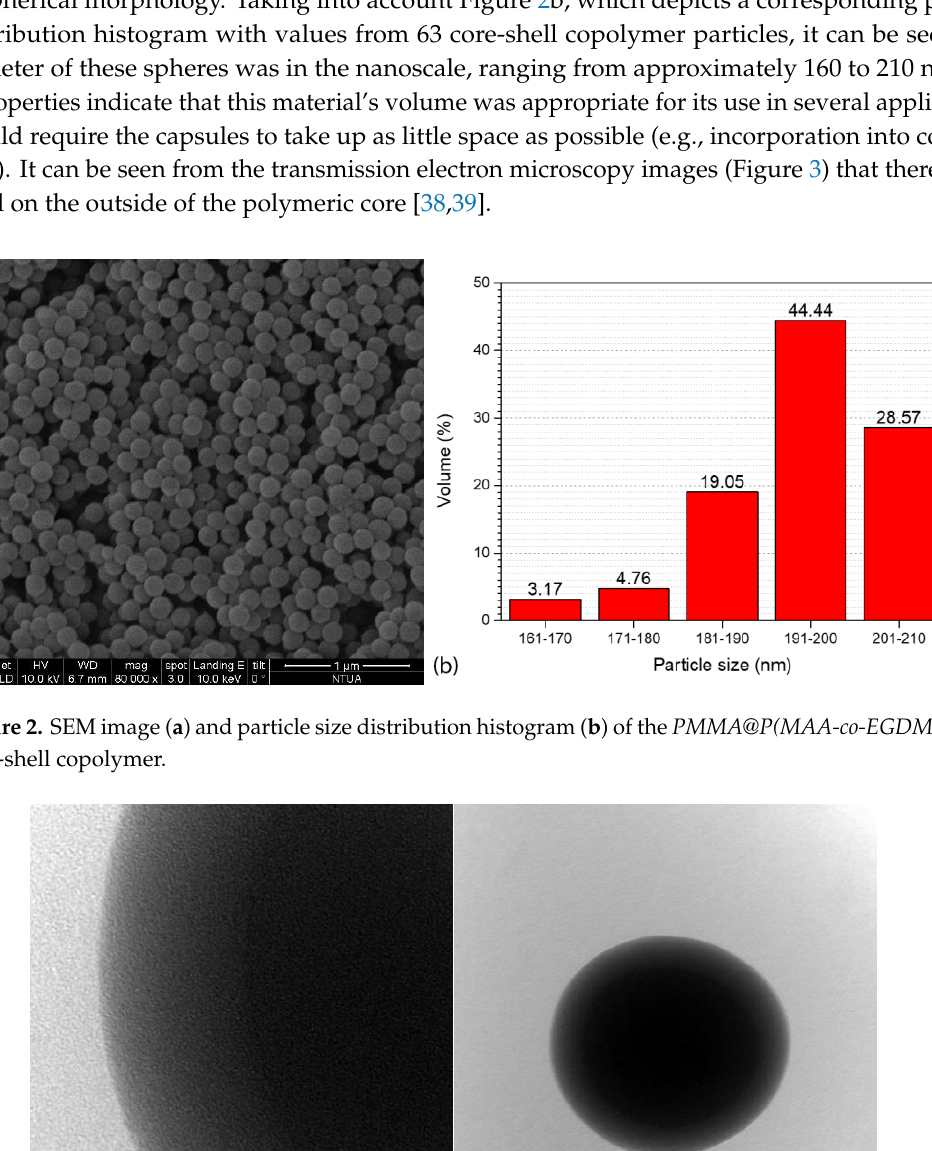
Figure 3. TEM images of the core-shell copolymer PMMA@P(MAA-co-EGDMA) .